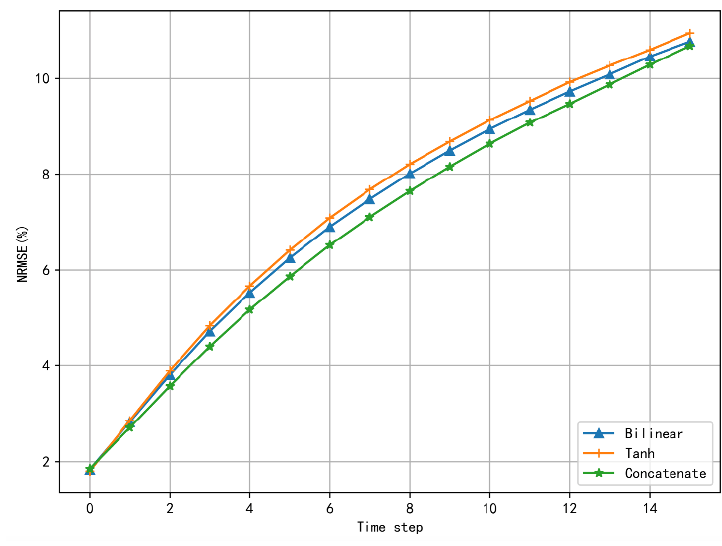
Figure 8. The comparison of different feature fusion method.